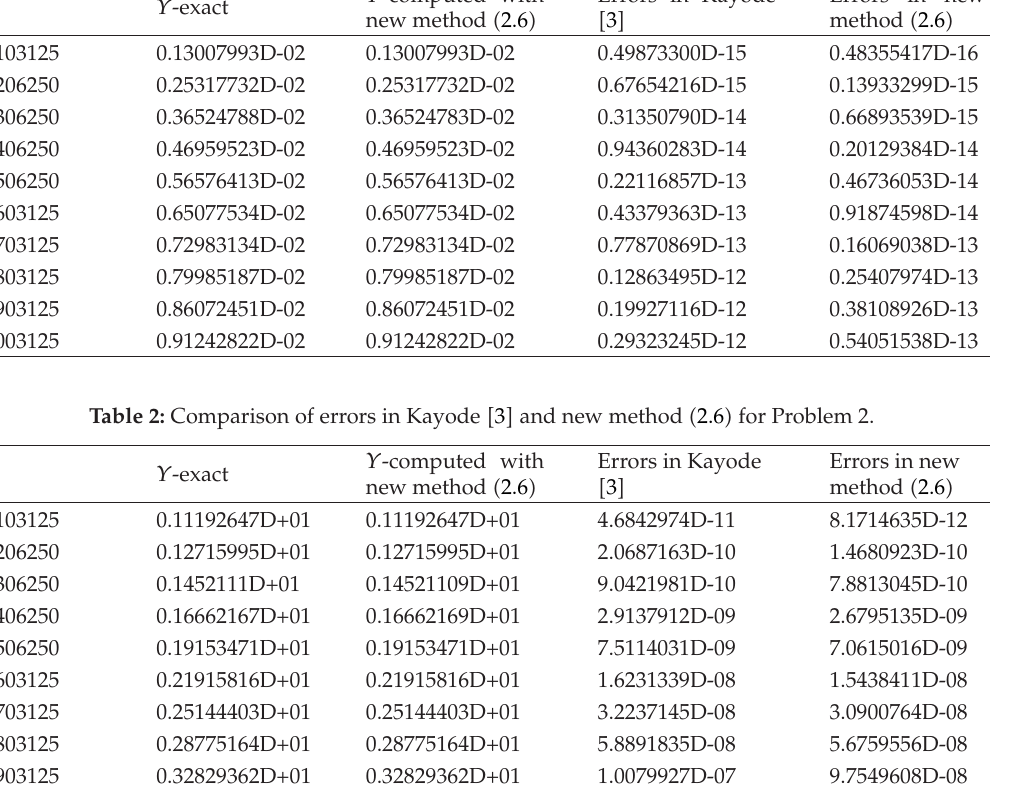
Table 1: Comparison of errors in Kayode (cid:7) 3 (cid:8) and new method (cid:3) 2.6 (cid:4) for Problem 1. X Y -exact